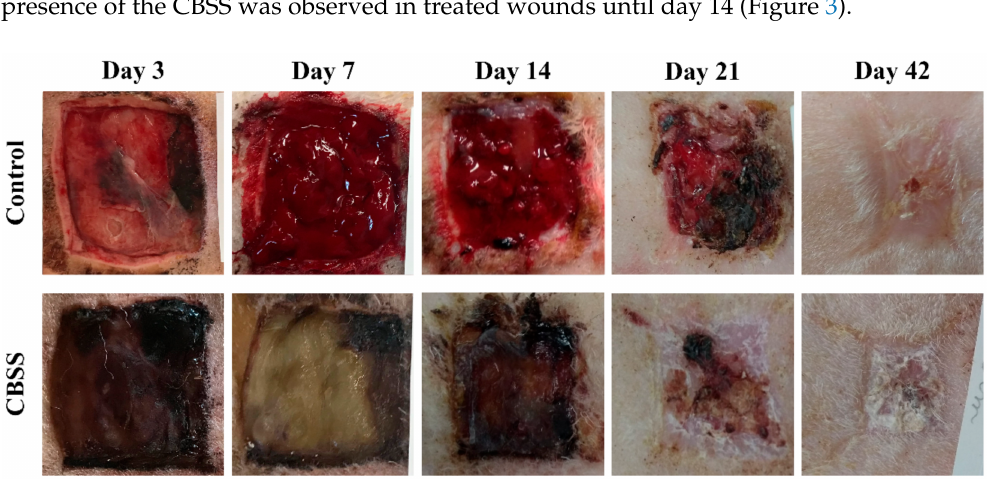
Figure 3. Representative images of the skin ulcers during wound healing.